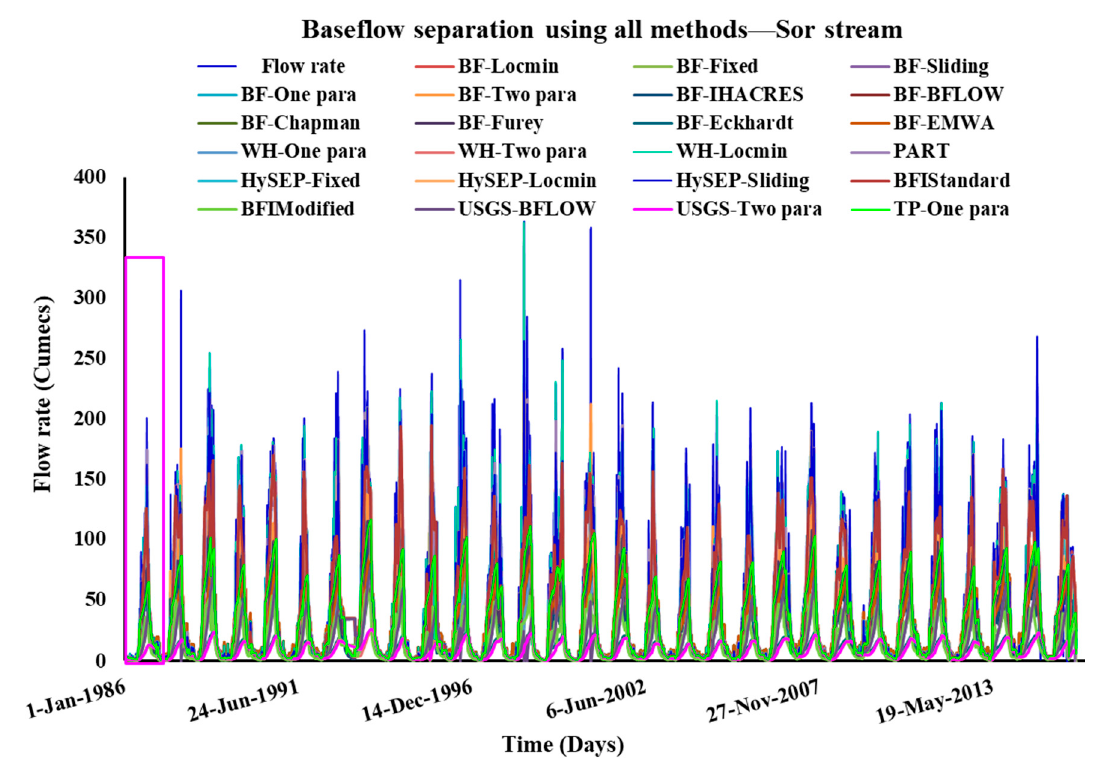
Figure 12. Baseflow separation using all automated methods for the Sor stream. (Results of all methods are displayed together. The figure is compacted and difficult to understand. Therefore, a detailed one-year baseflow separation result is shown in Figure 13. Each technique is further singled out and plotted in Figure 14. The following abbreviations were used for the summarized programs: BF is BFI+; USGS is USGS GW Toolbox; WH is WHAT; TP is timeplot and encircled as an example in Figure 14 for parameters, One para is one parameter, and Two para is two parameter).